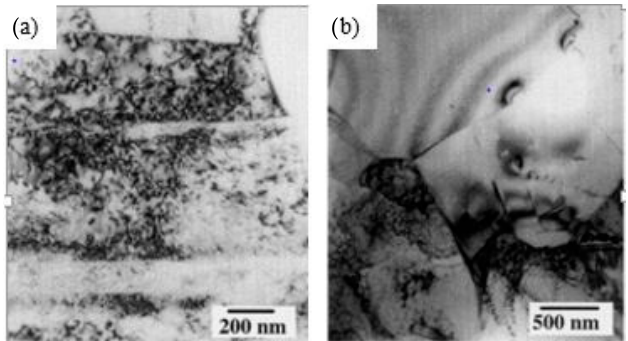
Figure 14. TEM on ( a ) LSP treated; ( b ) untreated specimen Ti6Al4V alloy. Reproduced with permis- sion from [116]. Copyright Elsevier, 1999.